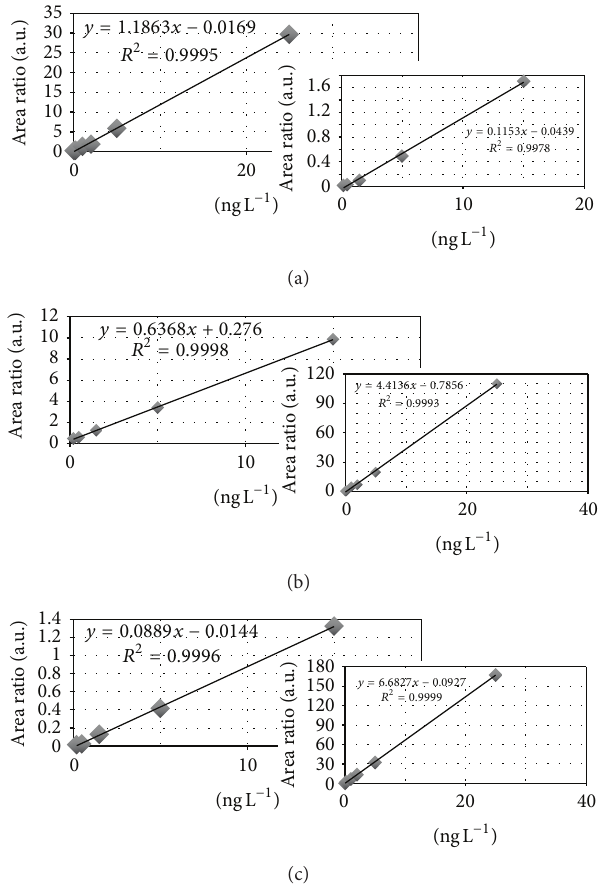
Figure 6: Matrix matched calibration curves for desflurane (a), sevoflurane (b), and HFIP (c) in the insert are reported as the corresponding curves in water.